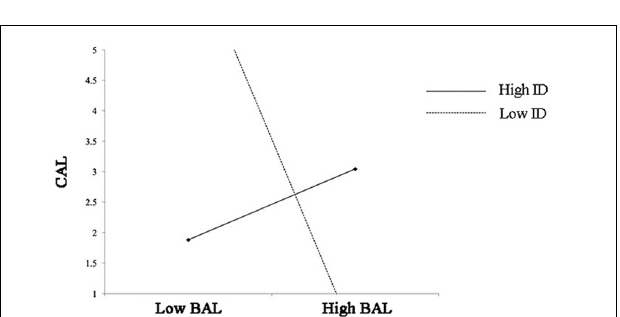
FIGURE 3 | Interaction between BAL and ID on